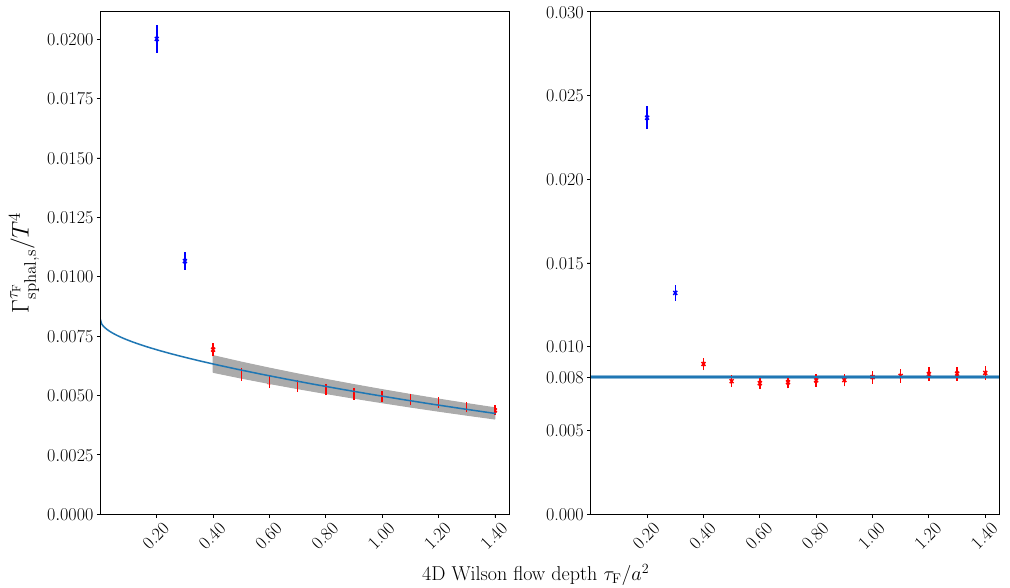
Figure 9 . Left: measurement of the sphaleron rate at different gradient-flow depths, where the points in red (representing different values of Γ τ F ) have been used to find the best fit for Γ sphal ,s sphal ,s (see equation (5.1)). The points in blue do not satisfy the criterion explained in a previous section, equation (4.3). Right: same plot but where each value has been corrected according to (5.1), and the horizontal line is the best fit described before. We see that the correction successfully accounts for the effects of 4D gradient